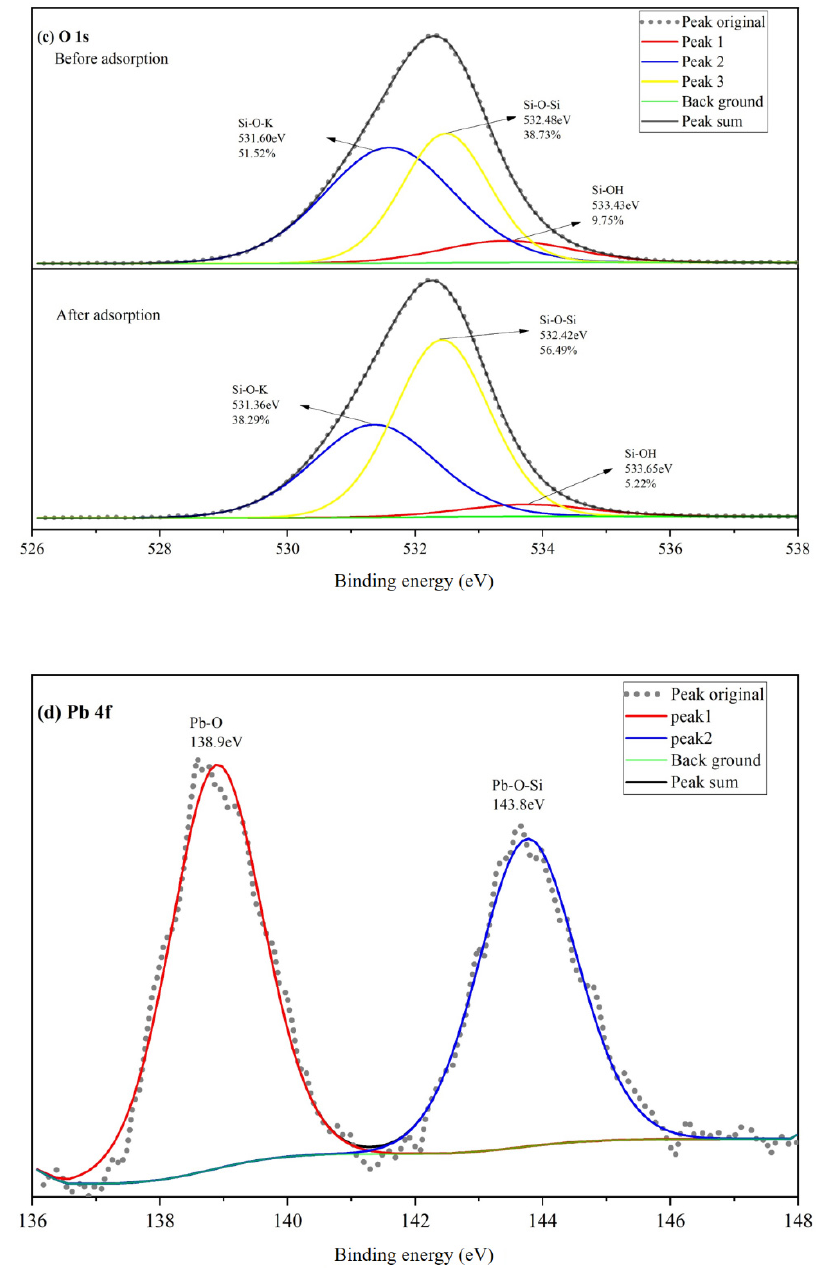
Figure 9. XPS spectra of SRC before and after adsorption: ( a ) Si 2p, ( b ) Al 2p, ( c ) O 1s, and ( d ) Pb 4f.